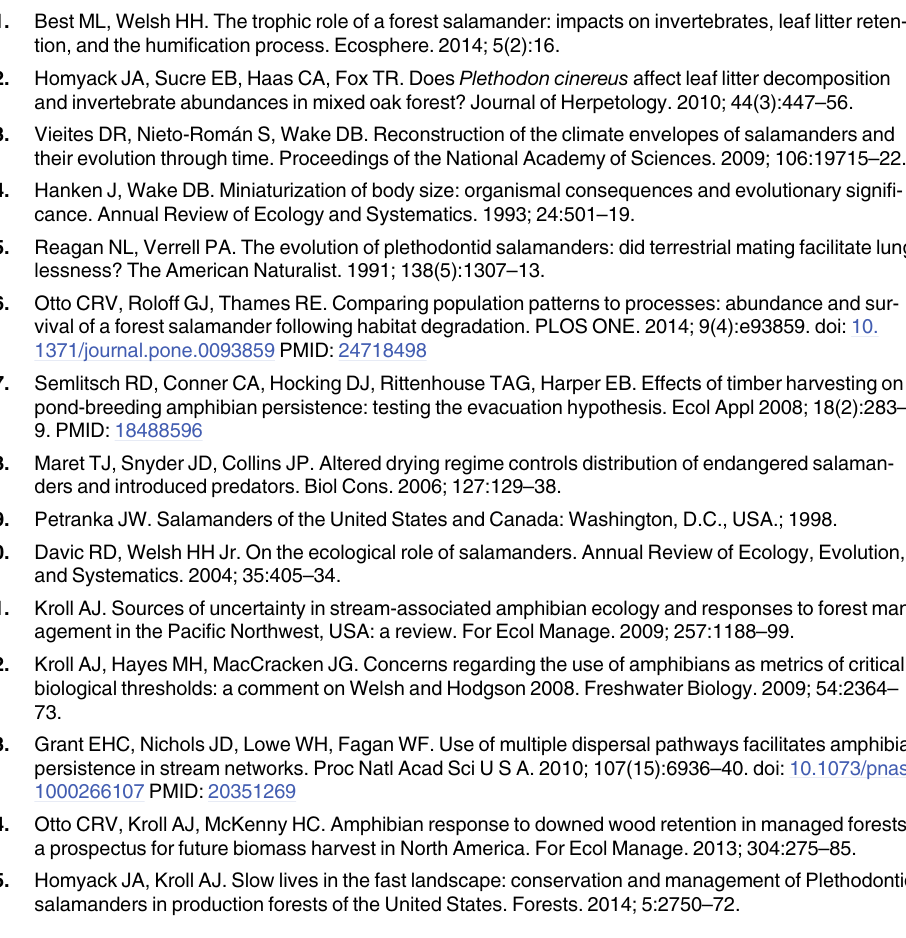
S5 Table. ‘ Hierarchical ’ BACI occupancy model simulation summary with alternative pri- ors. S6 Table. ‘ Multi-scale ’ BACI occupancy model simulation summary with alternative priors.